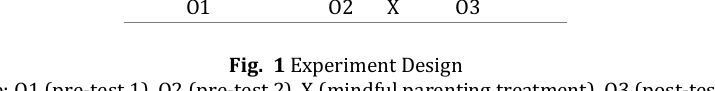
Fig. 1 Experiment Design Note: O1 (pre-test 1), O2 (pre-test 2), X (mindful parenting treatment), O3 (post-test)